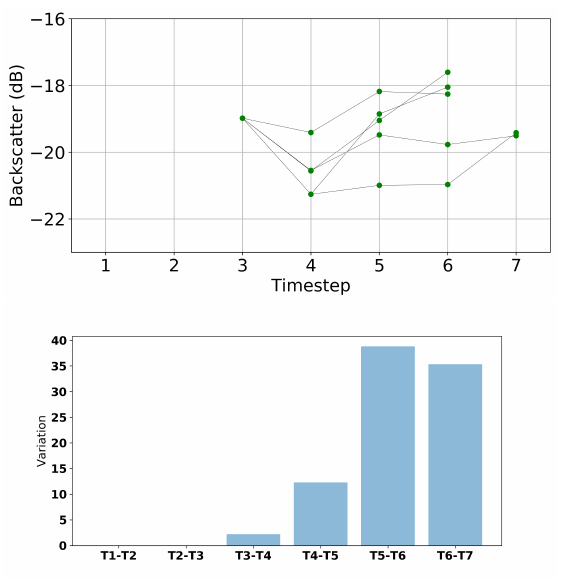
Figure 19. Temporal profile and variation VV polarisation in the descending SITS for the temporary entity in the dynamic zone.